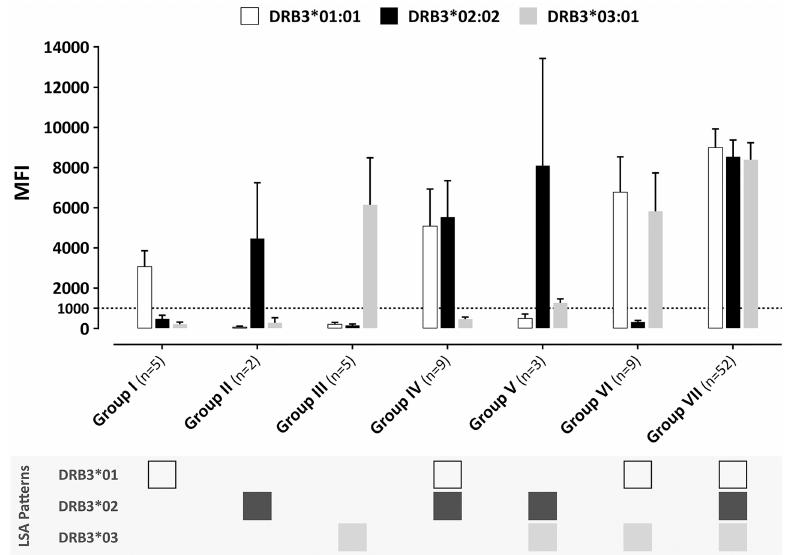
Fig 2. The reactivity patterns of HLA-DRB3 antibodies against Luminex SA microbeads. The reactivity patterns of HLA-DRB3 antibodies against three LSA microbeads (One Lambda and Immucor) in 85 patients. The groups represent all possible binding combinations of HLA-DRB3 antibodies in the sera of patients to one, two, or three microbeads coated with HLA-DRB3 (cid:3) 01:01, HLA-DRB3 (cid:3) 02:02, and HLA-DRB3 (cid:3) 03:01 proteins. A MFI value of (cid:21) 1000 was considered to be positive for HLA-DRB3. The data is plotted as mean and SEM. different: the sera of patients who do not carry the HLA-DRB3 gene (52 out of 67) showed an antibody reactivity primarily against all three microbeads (S2a Fig) (group VII), while the sera of patients who carry the HLA-DRB3 gene showed reactivity with specific DRB3 allele groups (S2b Fig).